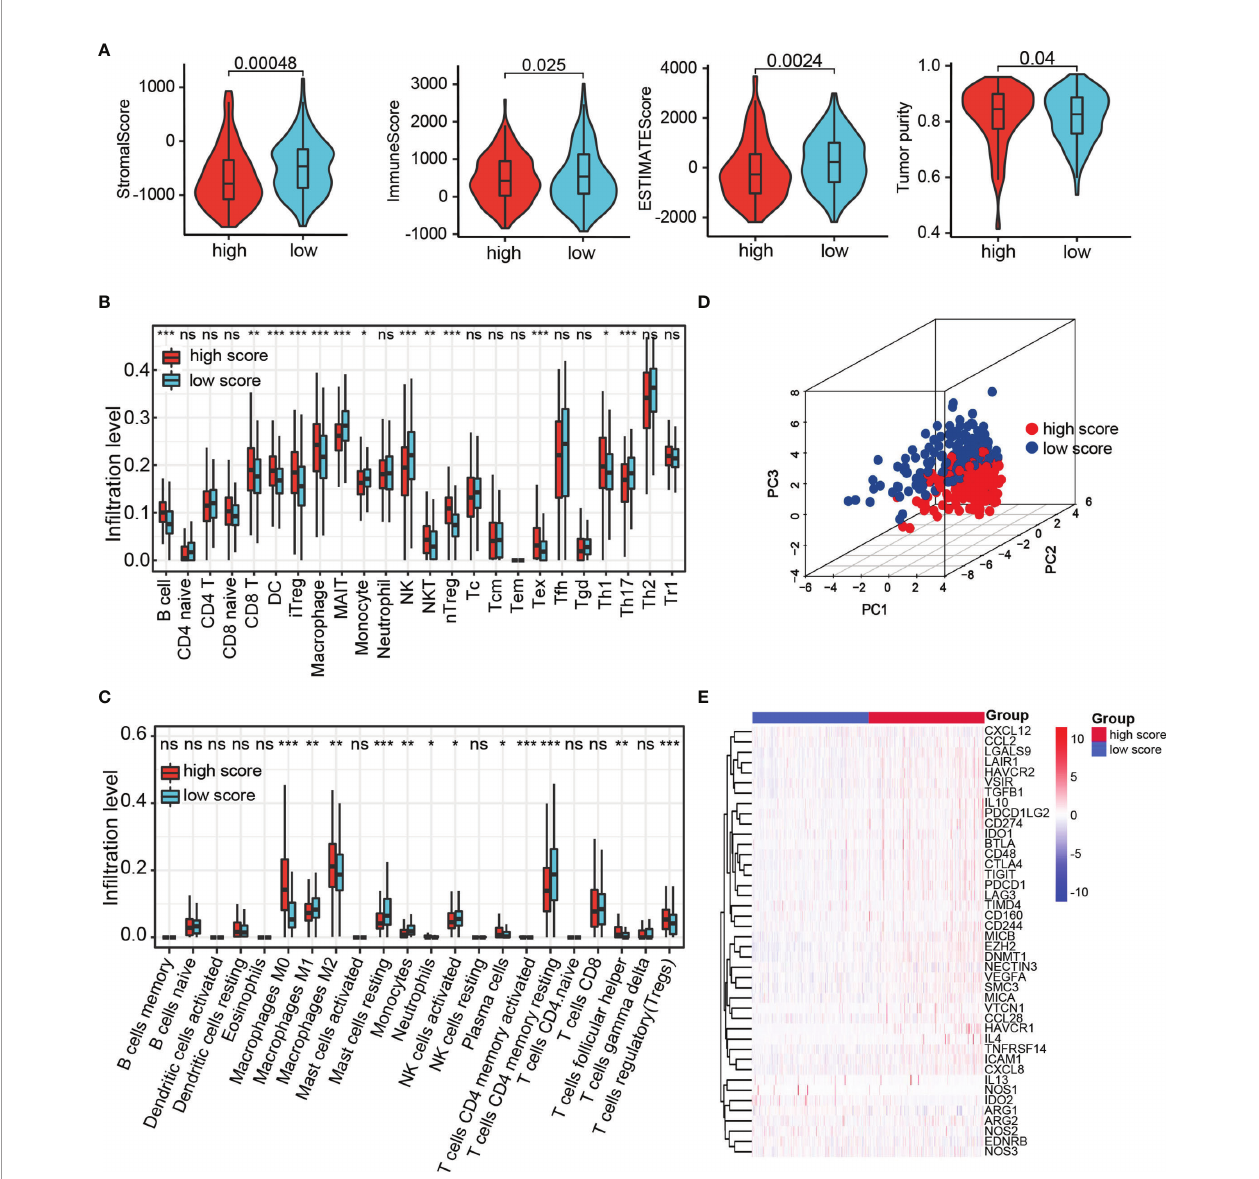
FIGURE 8 | The landscape of tumor immune microenvironment. (A) StromalScore, ImmuneScore, ESTIMATEScore, and Tumor purity between high- and low-risk group in TCGA. (B, C) Relative cell abundance immune cells by CIBERSORT and IMMUNECELL AI between two groups in TCGA. (D) PCA performed on HCC patients based on signi fi cant differences in immune cells between high- and low-risk groups. (E) Differentially expressed genes involved in the negative regulation of the cancer – immunity cycle between high- and low-risk groups. ns p > 0.05, * p < 0.05, ** p < 0.01, *** p <